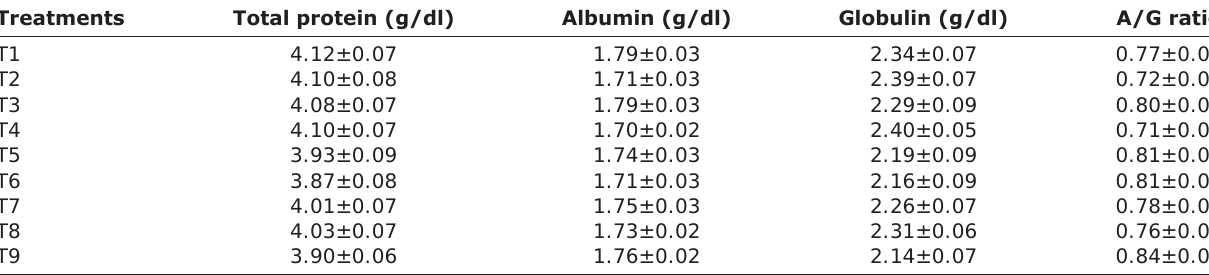
Table-4: Effect of feeding CSM on serum protein fractions in broilers. Treatments